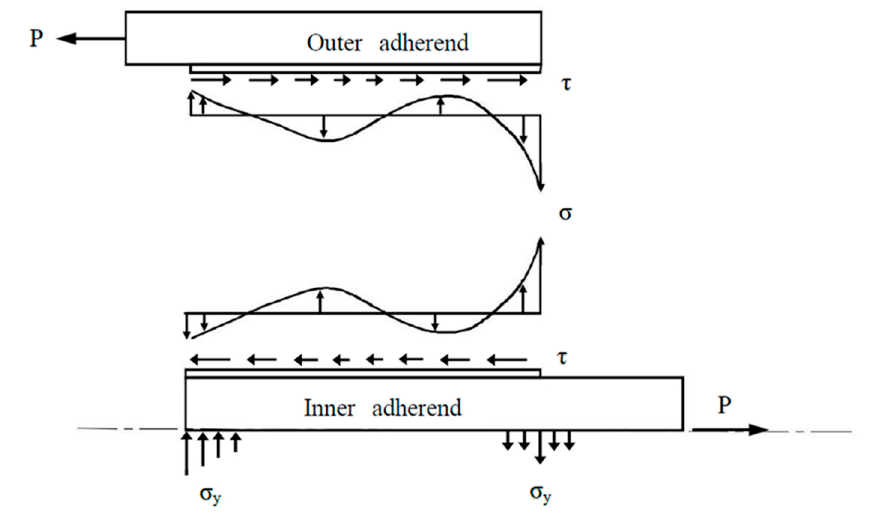
Figure 15. Schematic diagram of the interfacial stress distribution in the adhesive.